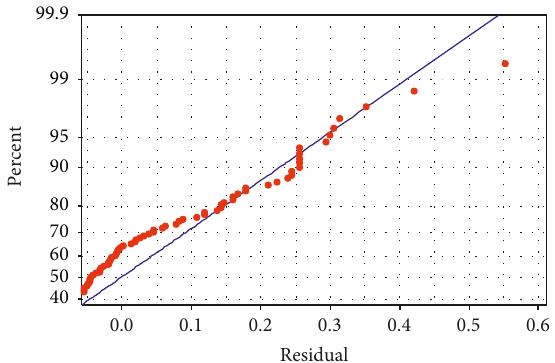
Figure 10: Normal probability plots.